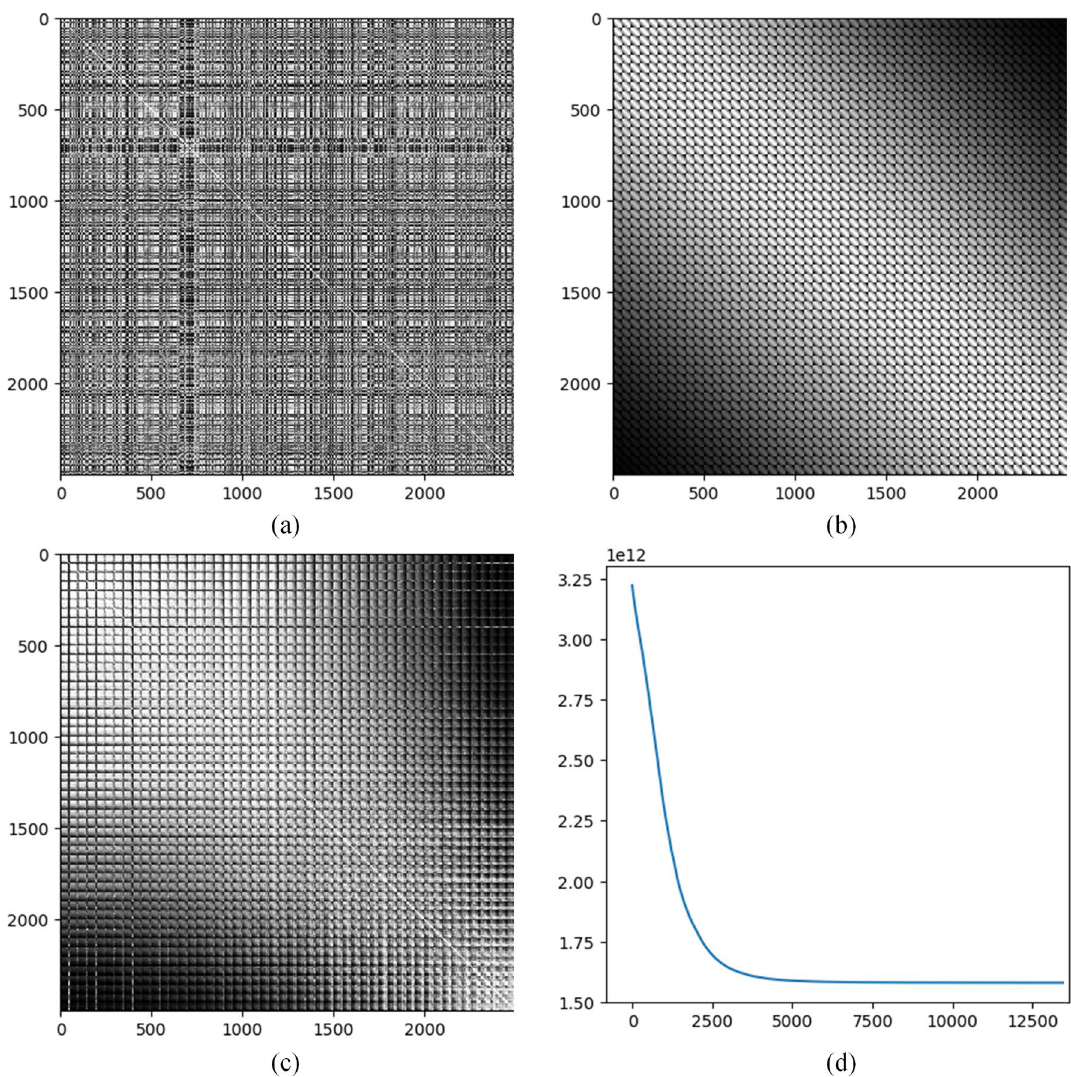
Figure 1. An illustration of IGTD strategy based on CCL gene expression data. ( a ) Rank matrix of Euclidean distances between all pairs of genes. The grey level indicates the rank value. 2500 genes with the largest variations across CCLs are included for calculating the matrix. ( b ) Rank matrix of Euclidean distances between all pairs of pixels calculated based on their coordinates in a 50 by 50 image. The pixels are concatenated row by row from the image to form the order of pixels in the matrix. ( c ) Feature distance rank matrix after optimization and rearranging the features accordingly. ( d ) The error change in the optimization process. The horizontal axis shows the number of iterations and the vertical axis shows the error